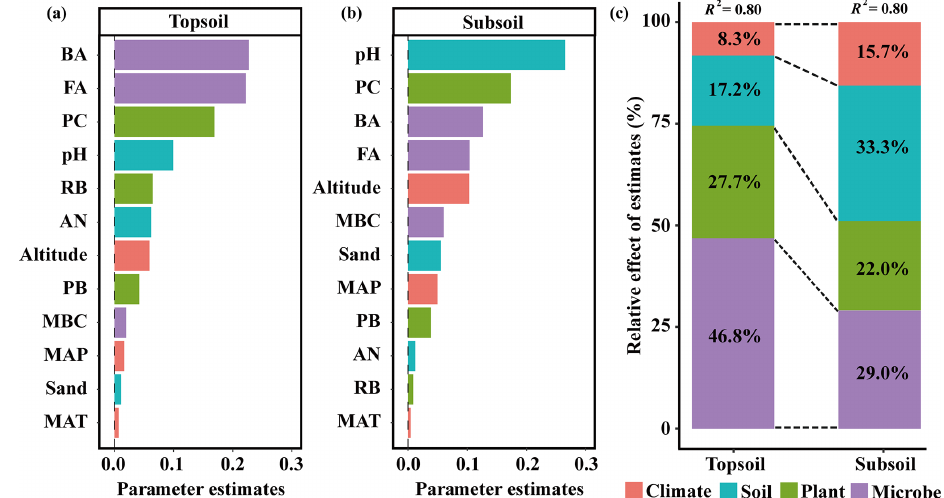
Figure 4. Relative effects of multiple drivers of SIC density in the (a) topsoil and (b) subsoil. Climatic variables include MAP, MAT and altitude; edaphic variables include pH, AN and sand proportion; plant variables include PB, PC and RB; microbial variables include MBC, BA and FA.